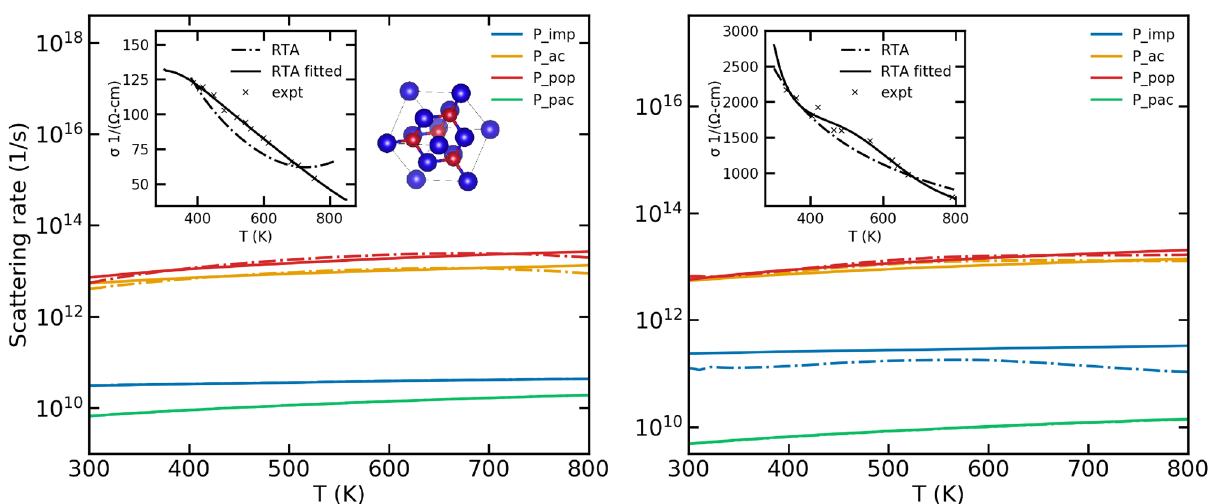
Figure 4. A comparison of the scattering rates in GaAs obtained using the original scattering models (labelled RTA) and those obtained using the fitting procedure (labelled RTA fitted) for samples of two different doping concentrations. The left panel corresponds to an n-type sample with a doping concentration of 3.5 × 10 17 cm − 3 while the right panel corresponds to an n-type doping of 7.7 × 10 18 cm − 3 . The inset shows the electrical conductivity calculated using both the original and the fitted scattering rates.The experimental data have been obtained from Ref. 32